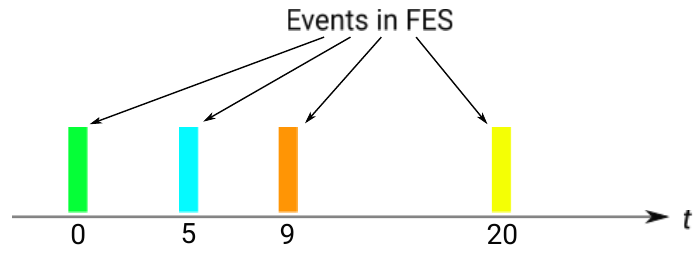
Figure 1. Discrete events at certain time